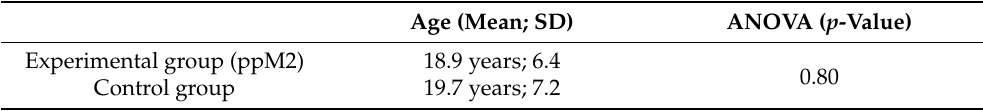
Table 4. COS depth and